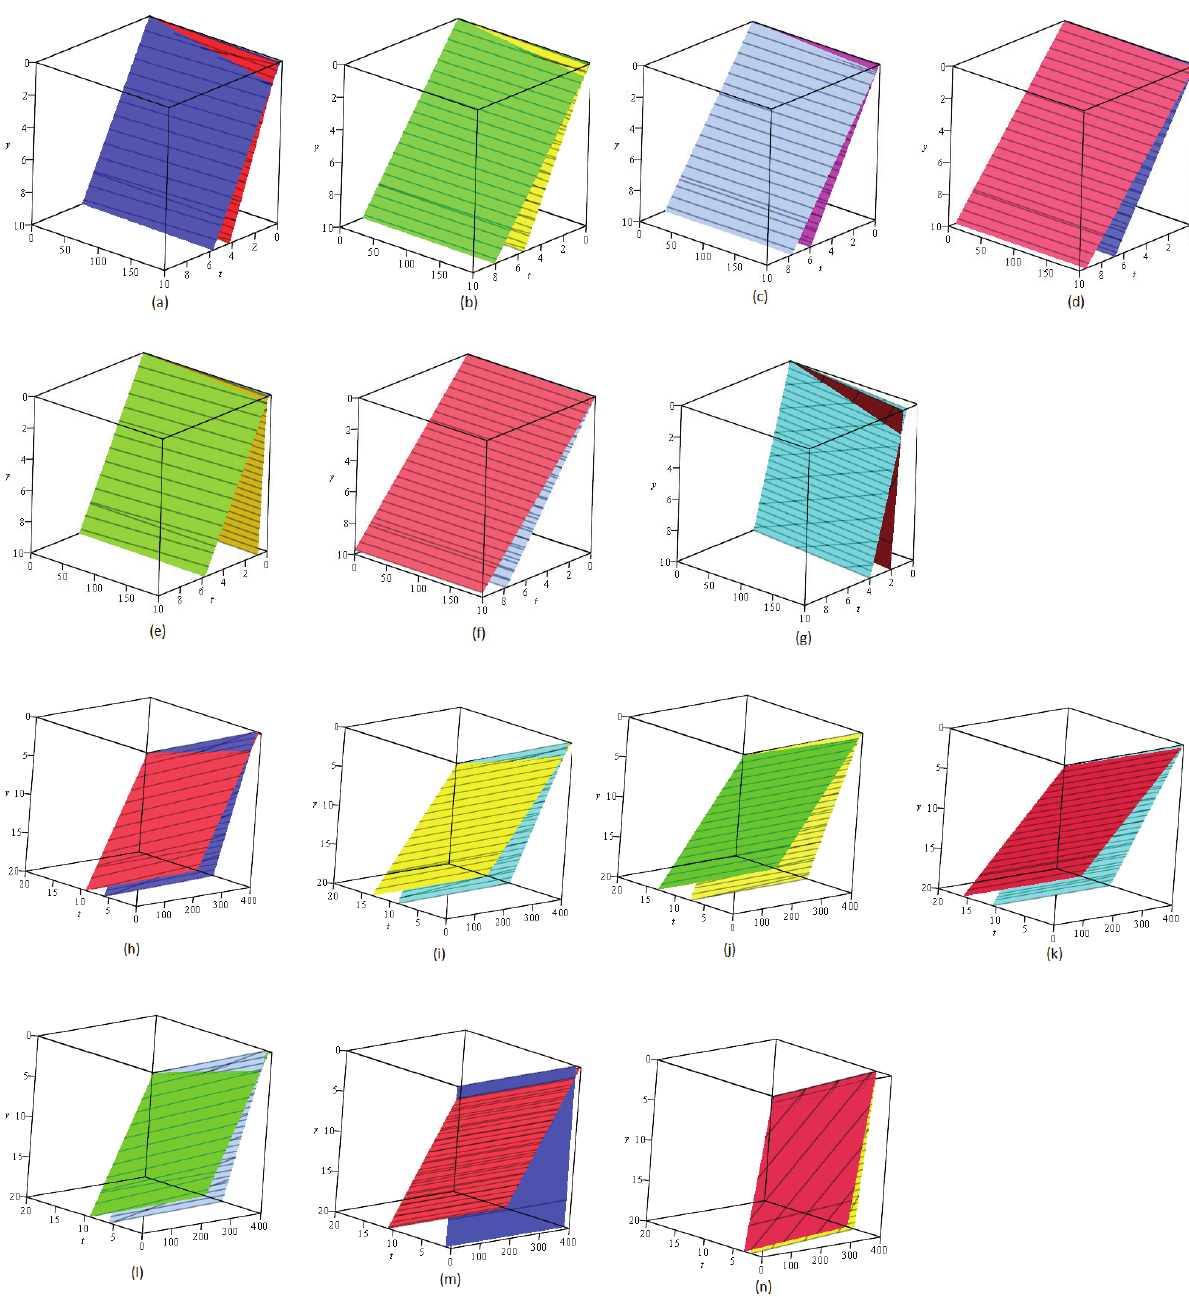
Figure 3: (a) 3D plot of M ( Γ ) and M c ( Γ ) are labeled in red and blue graphs; (b) 3D plot of M 1 1 graphs; (c) 3D plot of F ( Γ ) and F c ( Γ ) are labeled in purple and silver graphs; (d) 3D plot of ReZM ( Γ ) and ReZM c ( Γ ) are labeled in blue and red graphs; (e) 3D plot of M ∞ ( Γ ) and M cα ( Γ ) if α = 2, are labeled in golden and green graphs; (f) 3D plot of R red graphs; (g) 3D plot of SDD ( Γ ) and SDD c ( Γ ) are labeled in blue and mahogany graphs; (h) 3D plot of M and red graphs; (i) 3D plot of M ( Γ ) and M c ( Γ ) are labeled in sky blue and yello graphs; (j) 3D plot of F( Γ ) and F c ( Γ ) are labeled in golden and 2 2 green graphs; (k) 3D plot of ReZM ( Γ ) and ReZM c ( Γ ) are labeled in blue and red graphs; (l) 3D plot of M ∝ ( Γ ) and M cα ( Γ ) if α = 2, are labeled in silver and green graphs; (m) 3D plot of R ( Γ ) and R αc ( Γ ) are labeled in red and blue graphs; (n) 3D plot of SDD ( Γ ) and SDD c ( Γ ) are labeled in α golden and red graphs.